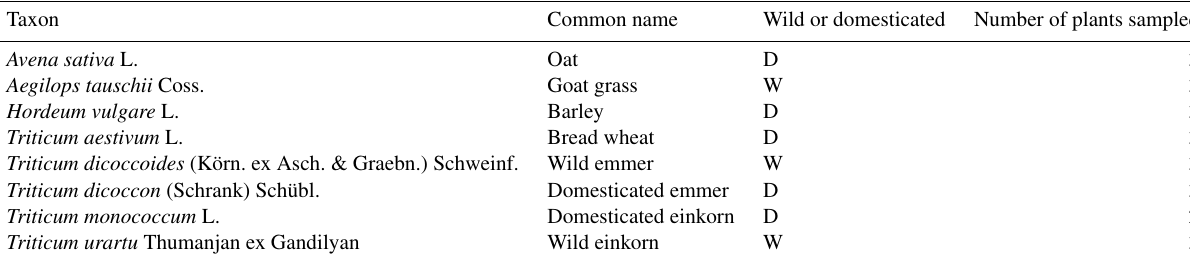
Table 1. Taxa included in the analysis. See Fig. 2c for pollen photographs for each taxon. Taxon Common name Wild or domesticated Number of plants sampled Avena sativa L. Oat D 3 Aegilops tauschii Coss. Goat grass W 3 Hordeum vulgare L. Barley D 3 Triticum aestivum L. Bread wheat D 3 Triticum dicoccoides (Körn. ex Asch. & Graebn.) Schweinf. Wild emmer W 3 Triticum dicoccon (Schrank) Schübl. Wild einkorn